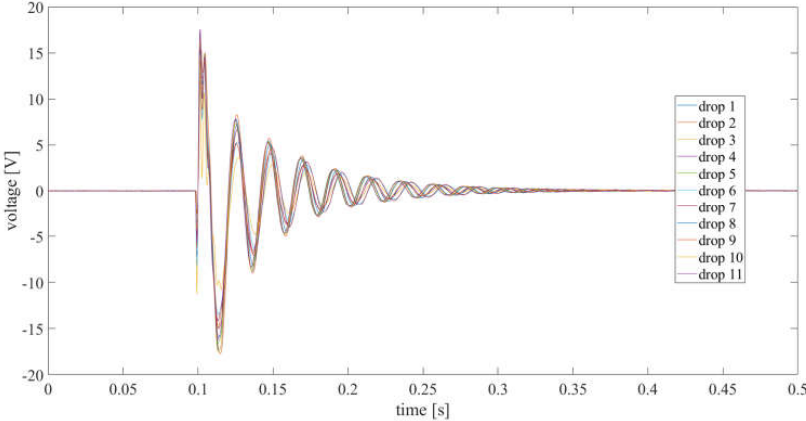
Figure 8. Voltage obtained at the ends of the structures due to a raindrop falling from 2.0 m and hitting the free edge.